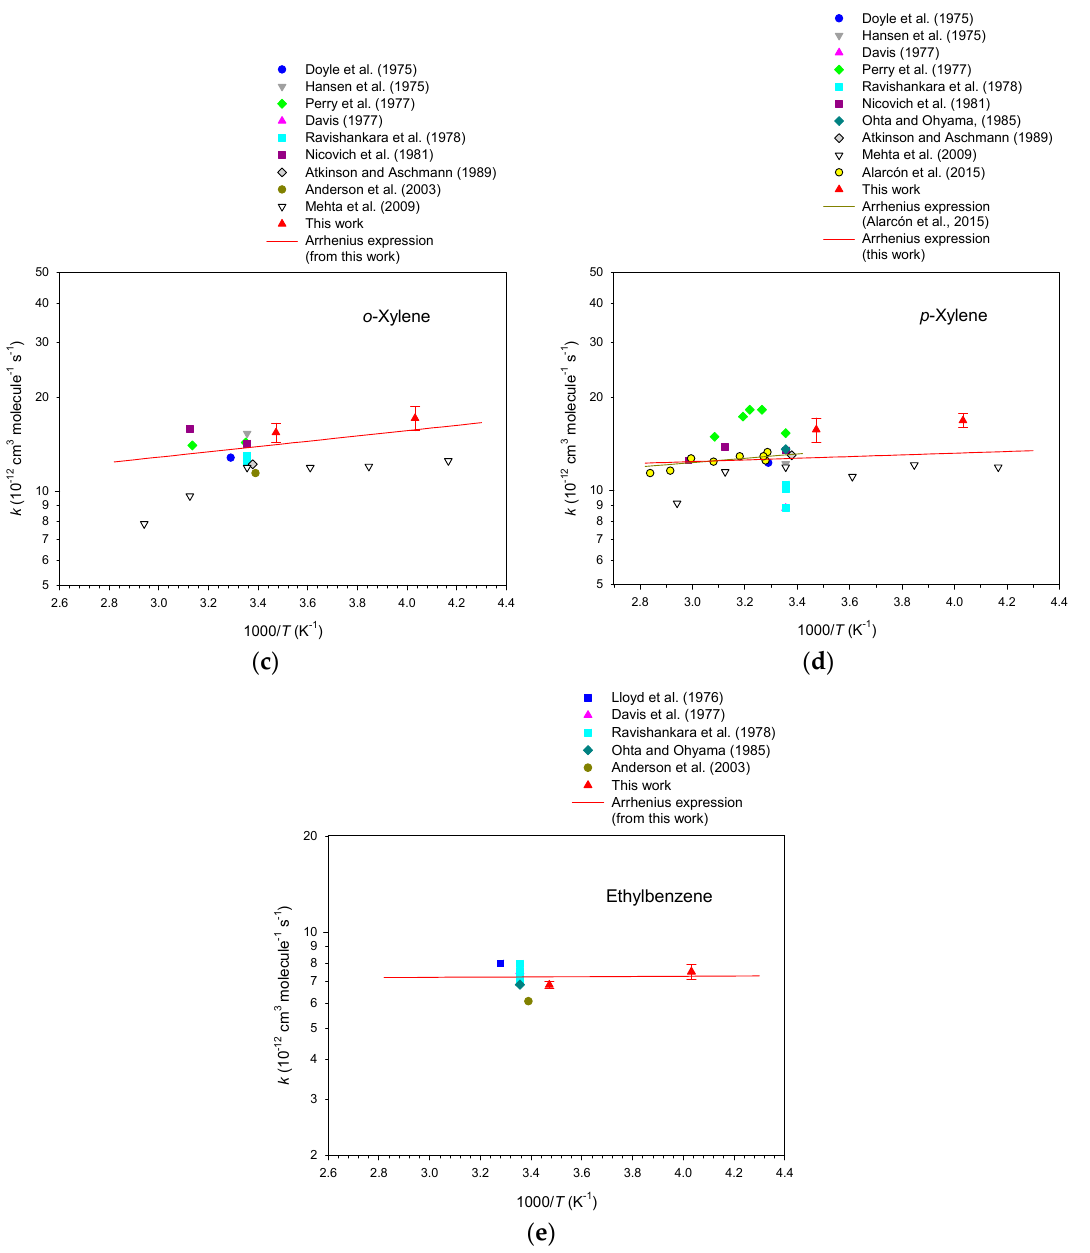
Figure 6. Arrhenius plots of the rate data for the reaction of OH radicals with aromatic hydrocarbons